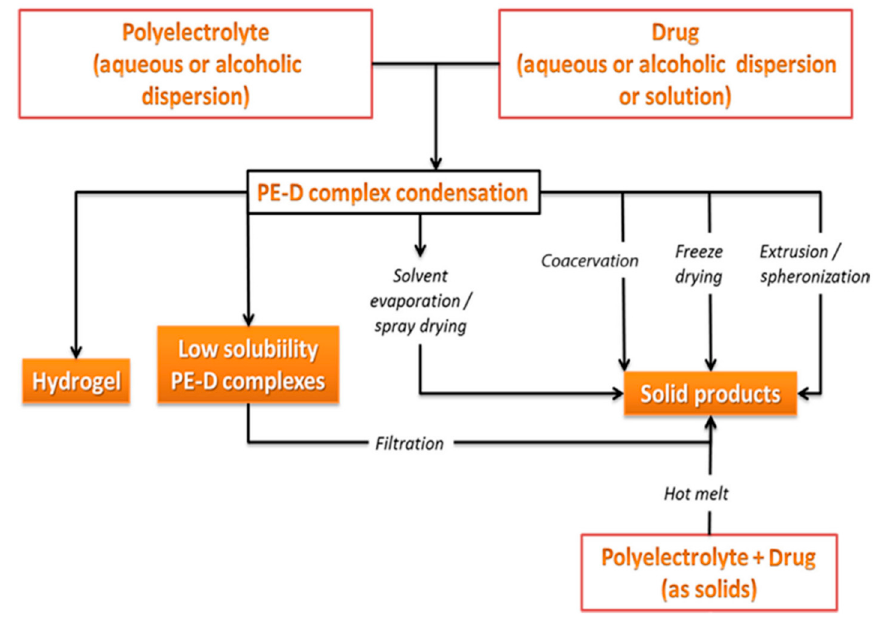
Figure 2. Reported processes for preparation of polyelectrolyte-drug formulations. (Adapted with permission from [46], Elsevier, Inc., 2017.)